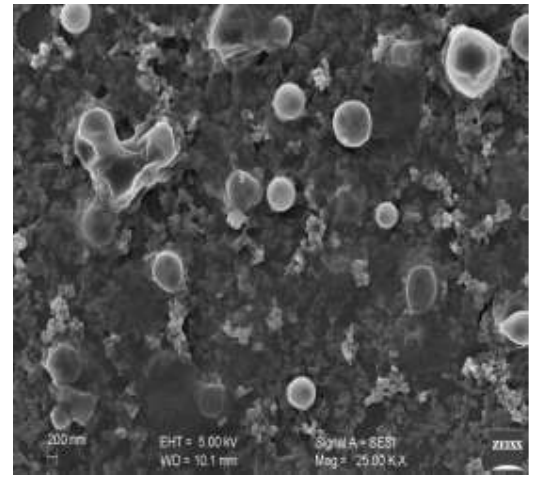
Figure.1. SEM image of 10% w/w 5-FU loaded PLGA